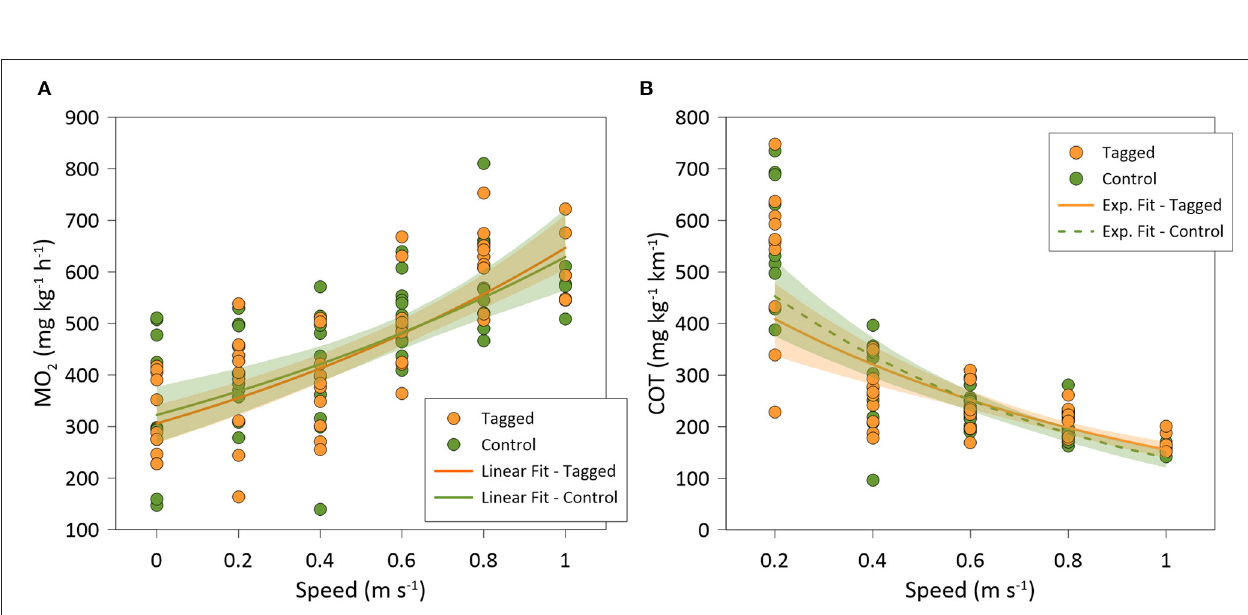
( Figure 6D ) (See Supplementary Figure 1 for further details). Seabream exhibited minimum mean TBF values at the lowest speed (mean: 1.68 ± 0.07 cycles s − 1 ) and the maximum TBF values at the highest speed (mean: 4.13 ± 0.34 cycles s − 1 ). There were no significant differences on TBF between tagged and non-tagged seabream (GLMM, p =